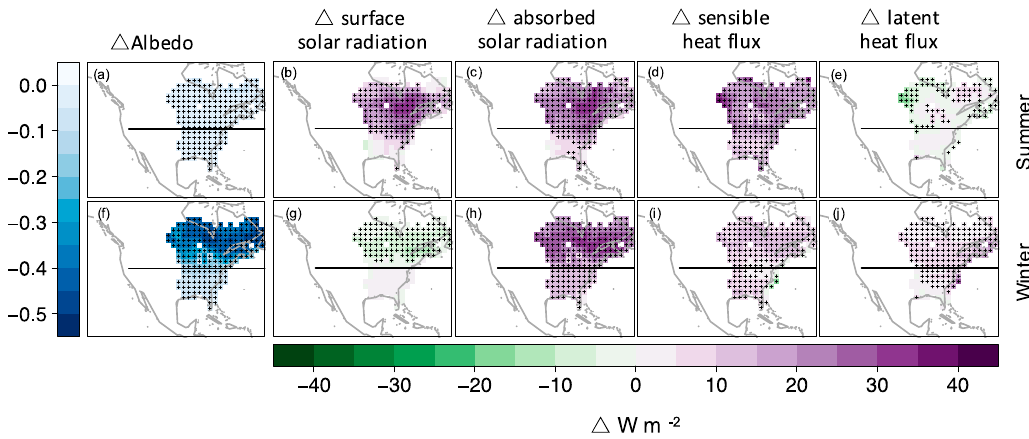
Figure 3. The influence of afforestation in eastern North American on albedo ( a , f ), solar radiation passing through the atmosphere to reach the land surface ( b , g ), solar radiation absorbed by the land surface ( c , h ), sensible heat exchanged between the land surface and the atmosphere ( d , i ), and latent heat exchange between the land surface and the atmosphere ( e , j ). Summer and winter months are shown for afforestation using a broadleaf deciduous tree type with an LAI of 4. The stipples denote statistical significance between simulations at the p < 0.05 level. The horizontal line denotes the northern and southern extents used in the analysis. Albedo is the ratio of outgoing to incoming solar radiation. Solar radiation, sensible heat flux, and latent heat flux are expressed as the change in energy flux, defined as a watt m − 2 (equivalent to a Joule m − 2 s − 1 ). In the southern extent of the region, the temperature change associated with forest management change (tree type and LAI) was larger than that caused by a land-cover change (afforestation),